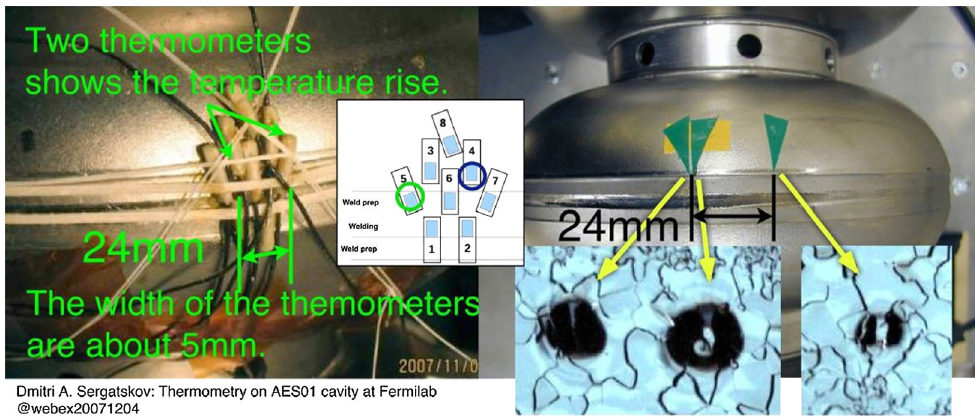
FIG. 6. (Color) Positions of the two hot spots found at FNAL (left) and those found at Kyoto (right). The inset of the left figure shows the location of the thermometers. The two thermometers (#4 and #5) that showed an abnormal temperature rise are marked. (Courtesy of FNAL/JLAB.)